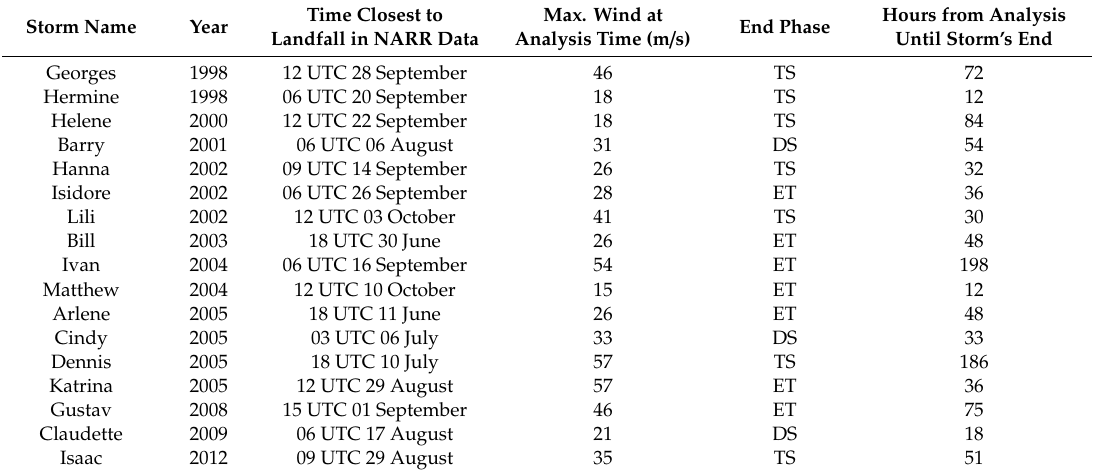
Table 2. As in Table 1 but for central group TCs.